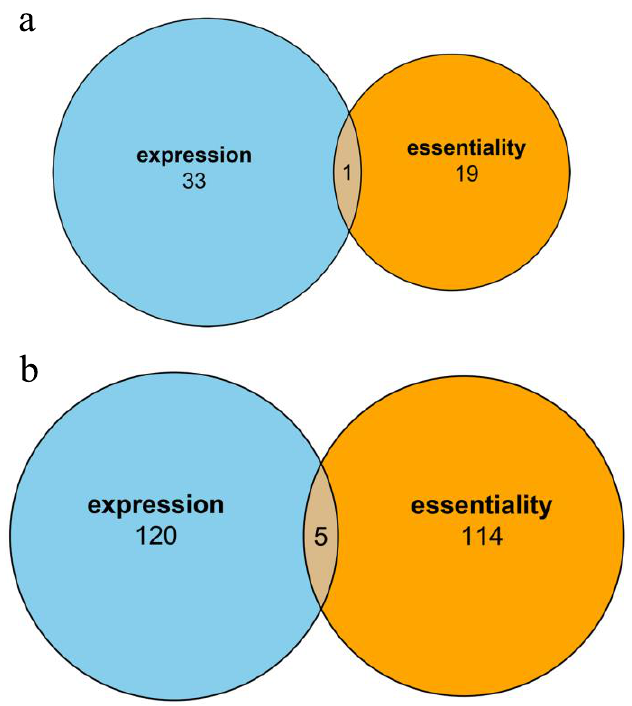
Figure 4. Venn plots illustrating results between gene expression and essentiality. ( a ) Number of significant drug combination-gene relationships using gene expression and essentiality, ( b ) number of significant drug combination-pathway relationships using gene expression and essentiality.